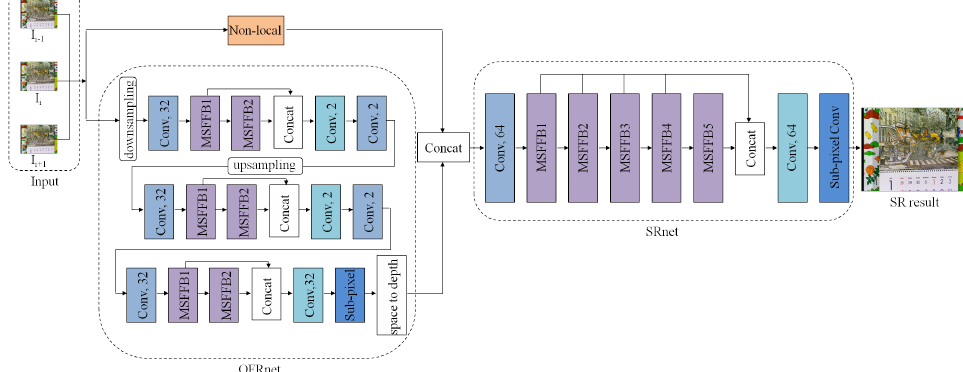
Figure 2. The framework of the proposed video super-resolution